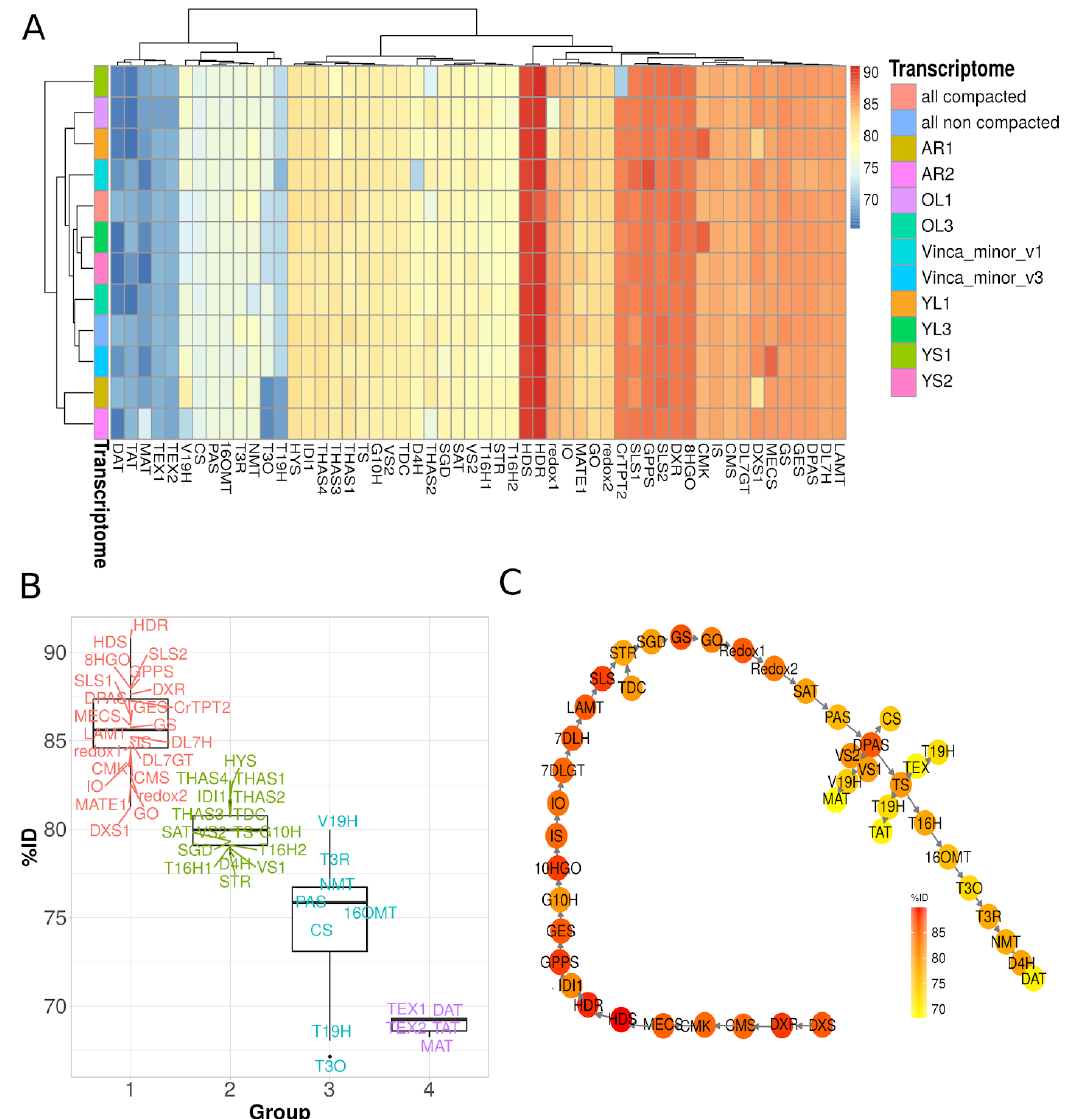
Figure 5. Comparison of V. minor transcripts to C. roseus reference sequences from the MIA pathway. ( A ) Percent of identity was calculated with blastn for each V. minor assembly against C. roseus MIA nucleotide sequences. ( B ) Average %ID per group of genes in the V. minor consensus assembly. ( C ) Comparison of V. minor consensus assembly homologs to the elucidated C. roseus vinblastine pathway.